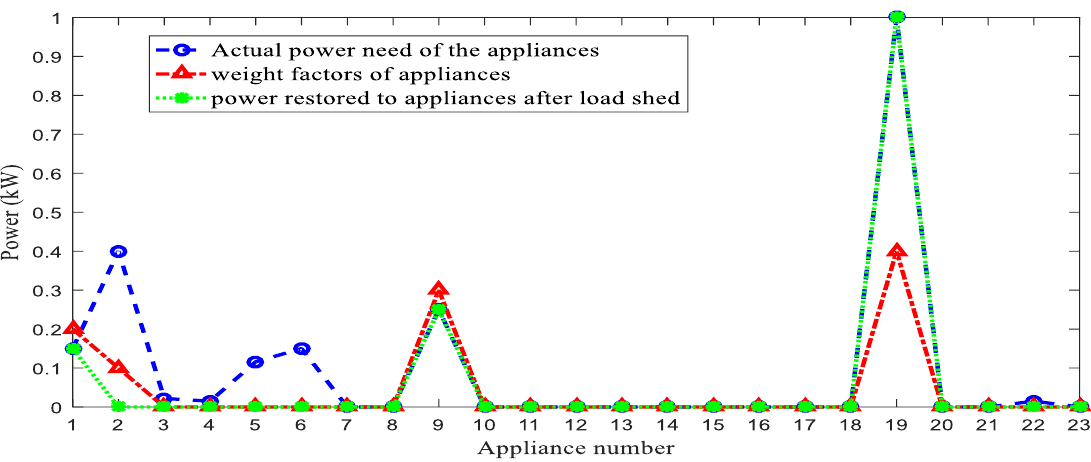
Figure 8. Actual load to meet, factors assigned for priority of appliance, and power restored due to EVs for residential user 2.